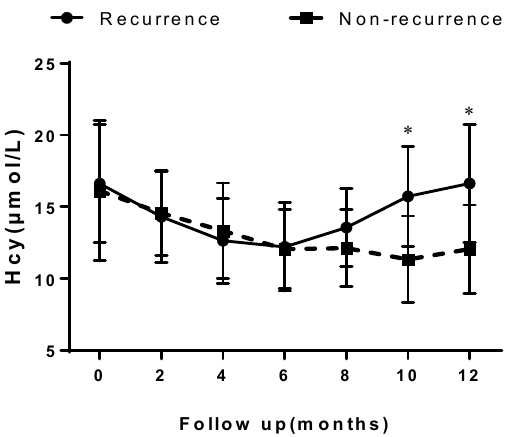
Figure 1: Serum Hcy dynamic changes in recurrence and non- recurrence colorectal cancer patients prior and post-operation (0 month means prior surgery).